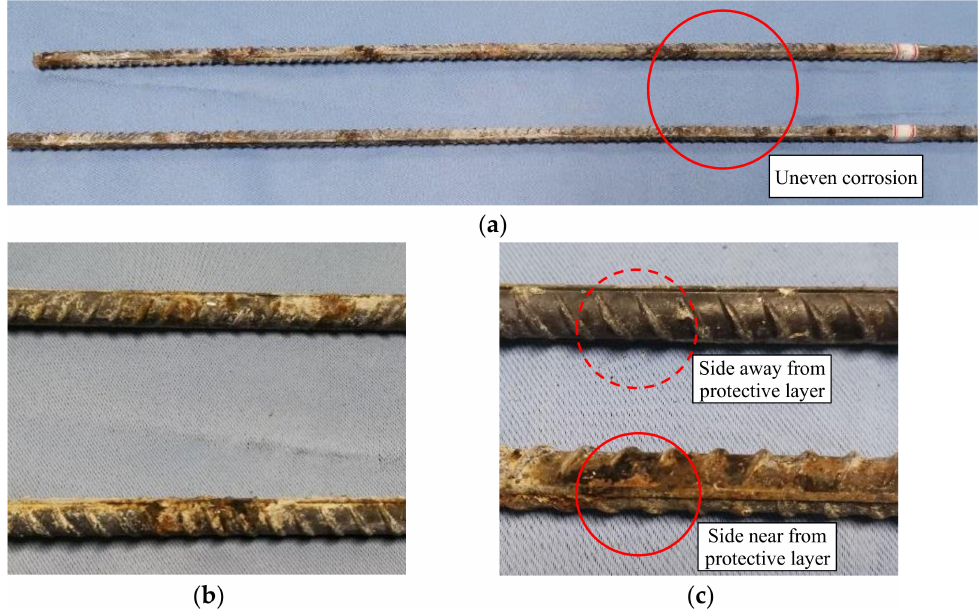
Figure 18. Uneven corrosion of reinforcement ( a ); Partial drawing of corroded reinforcement of No.2 beam ( b ); Contrast drawing of reinforcement corrosion near/away from protective layer ( c